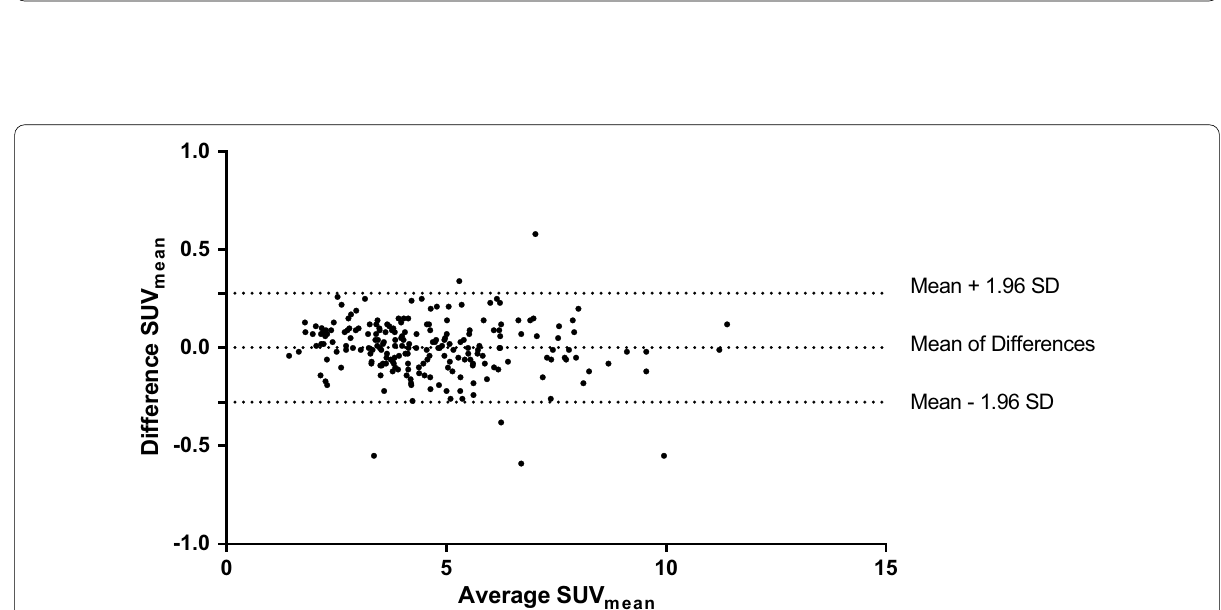
Fig. 5 Bland–Altman plot showing SUV max measurement differences of 214 lesions between the 75 s and 57 s PET/CT datasets plotted against the mean SUV max . In order to interpret these powerful Bland–Altman plots properly, it is essential to know that the differences between the quantified SUVs are plotted on the y- axis and the average of the SUVs is visualized on the x- axis